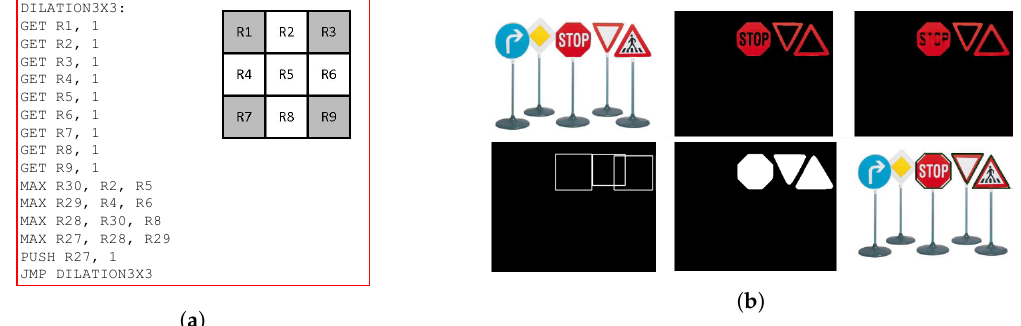
Figure 13. ( a ) The simplified IPPro assembly code of 3 × 3 dilation operation. ( b ) The output result of implemented design.